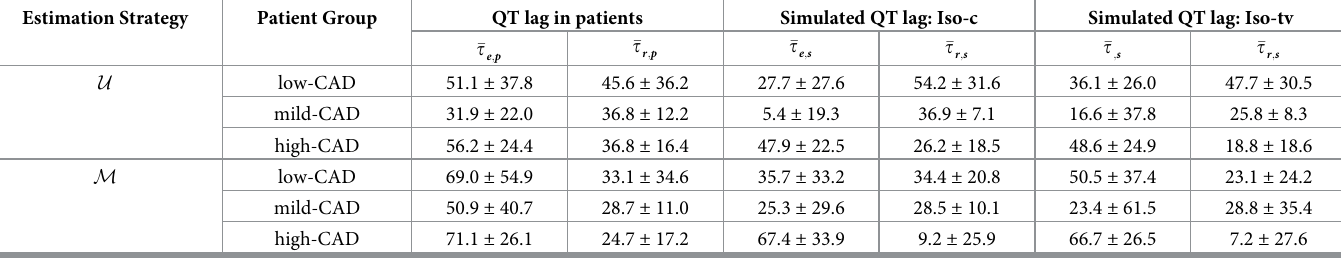
Table 3. Average values of the QT adaptation delays � t � t and � t , with constant β -adrenergic stimulation (fourth column) and with the proposed time-varying β -adrenergic stimulation (fifth e ; s r ; s